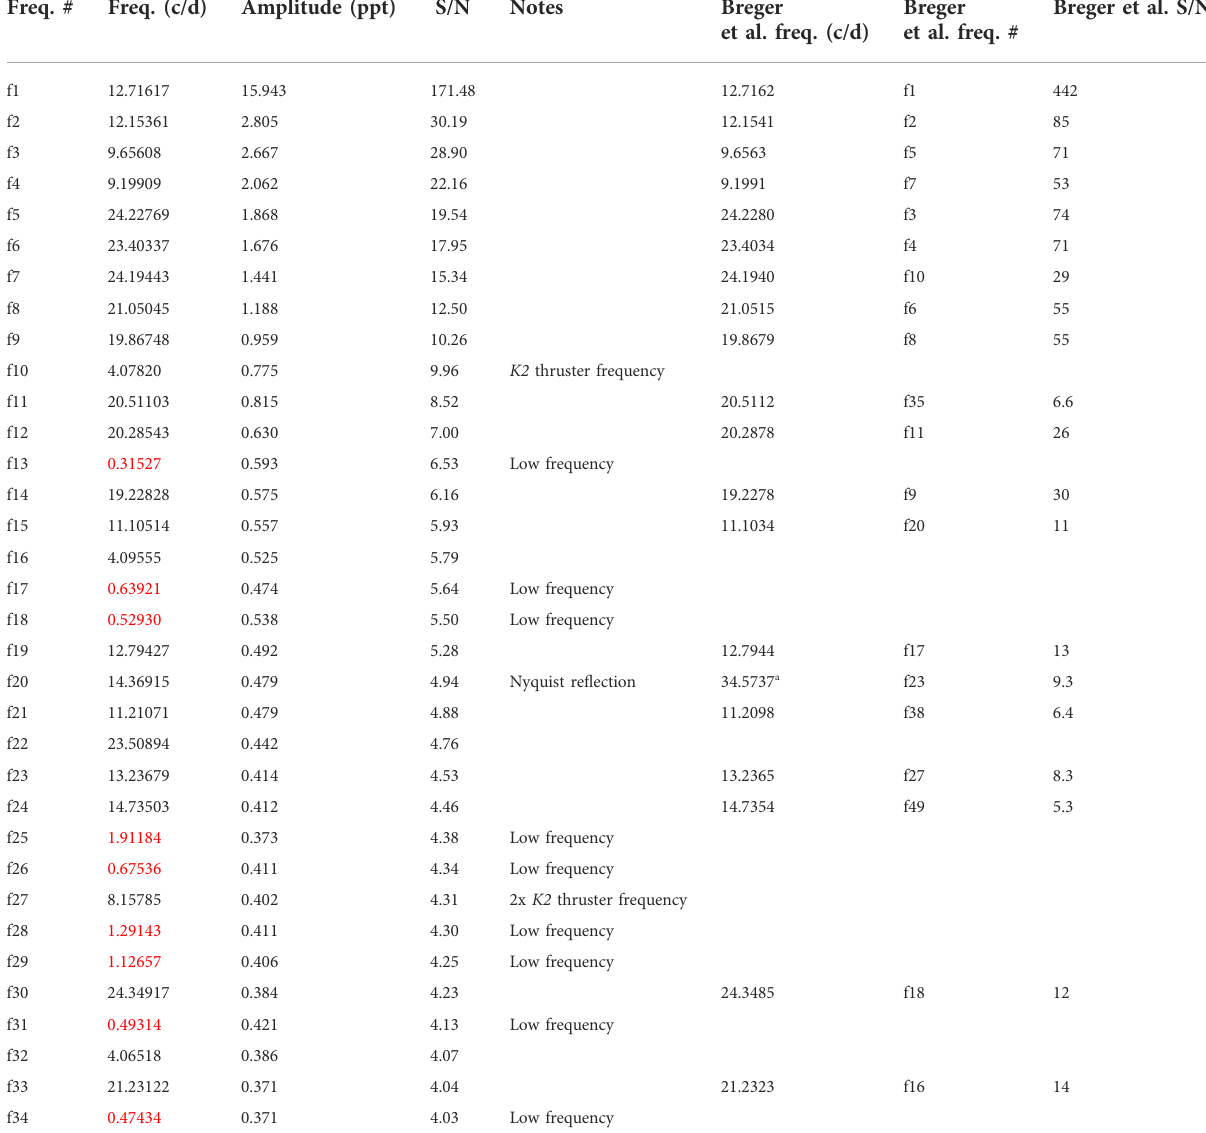
TABLE 1. FG Vir K2 frequencies in order of S/N compared with Breger et al. (2005) frequencies. Low frequencies between 0.3 and ~3 c/d are highlighted using red font. The calculated uncertainties in K2 frequencies and amplitudes, respectively, are 4.22×10 − 4 c/d and 50.1 ppm. Freq. # Freq.